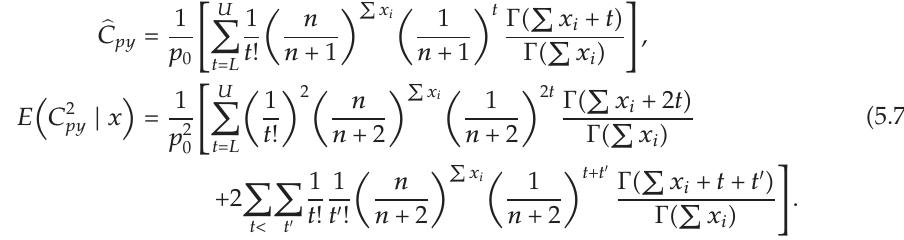
(cid:7) 0, U (cid:7) 10, samples generated from normal